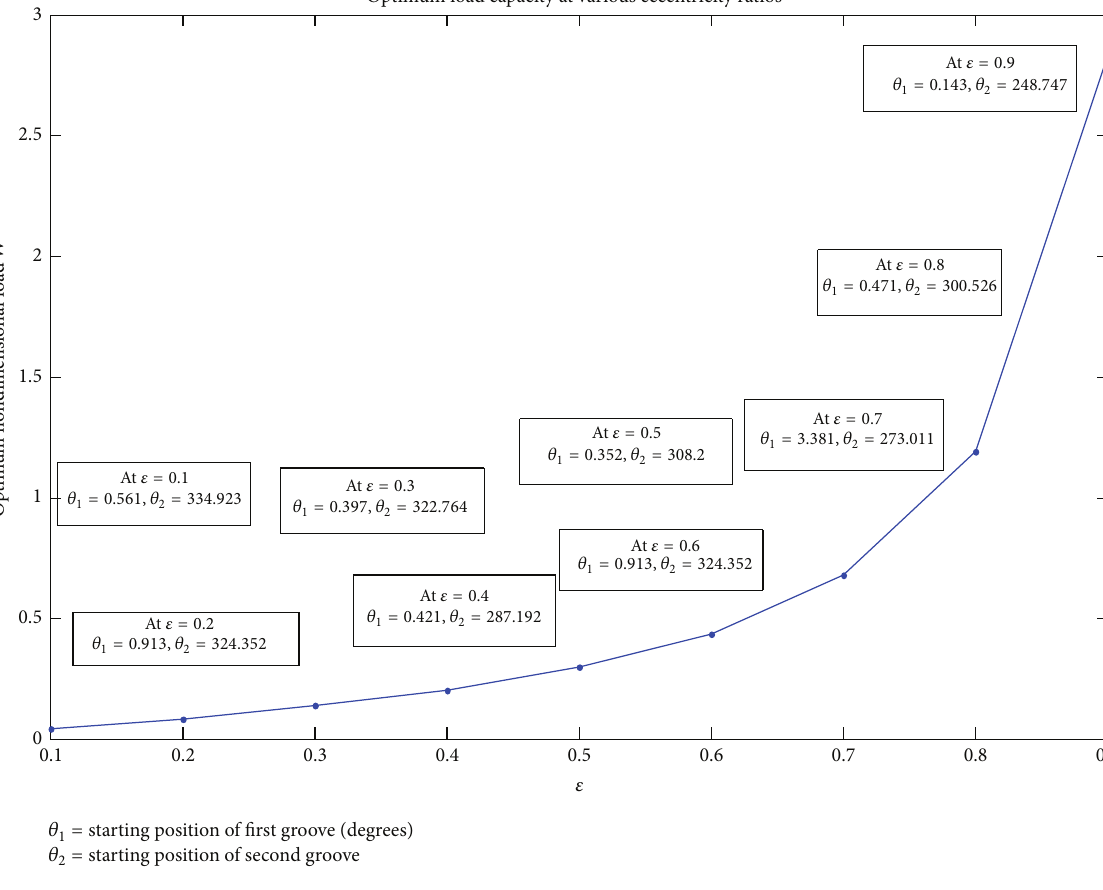
Figure 12: Variation of optimum nondimensional load at different eccentricity ratios.